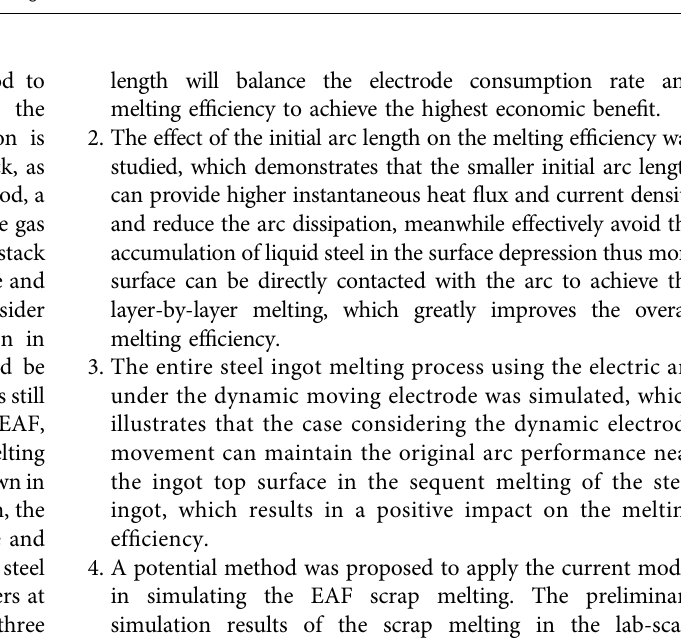
FIGURE 12 | Steel ingot stack melting using electric arc with dynamic moving